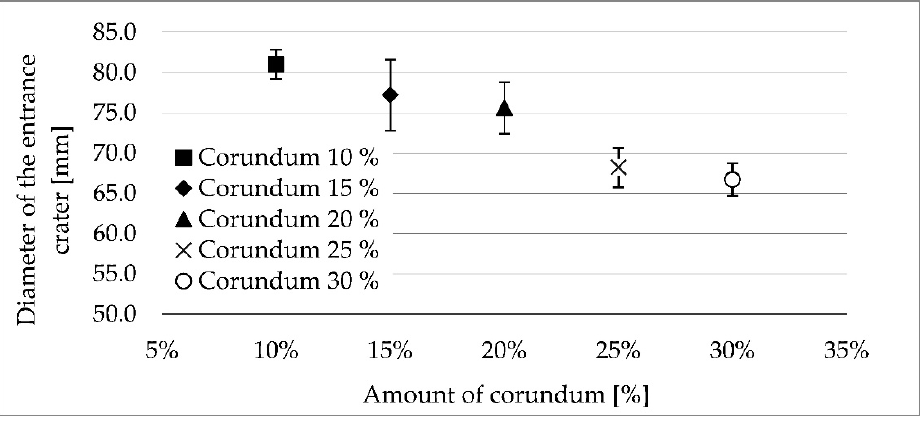
Figure 12. Diameter of the entrance crater according to the individual percentage substitutions.